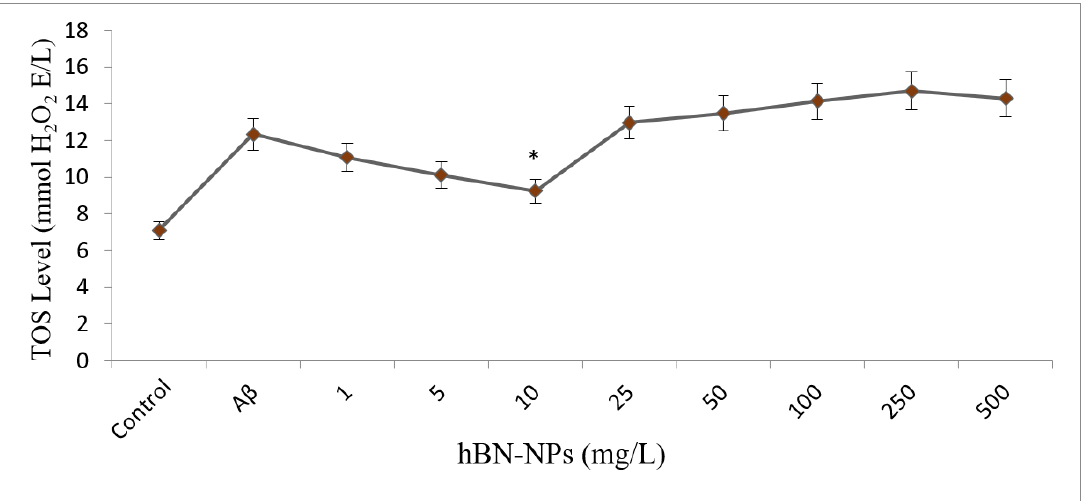
Figure 10. Effects of hBN-NPs and A β treatments on TOS levels in differentiated SH-SY5Y cells. (Control: Cells without hBN-NPs. * Symbol presents significant differences at the p < 0.05 level from the A β group).